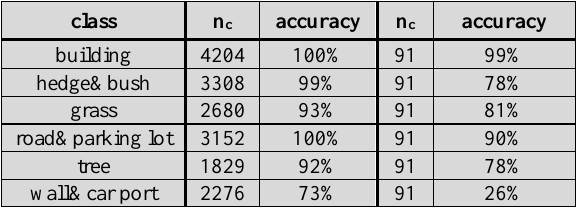
Table 9. User’s accuracy determined either by 17449 training points or by 546 independent points (DT-classification)